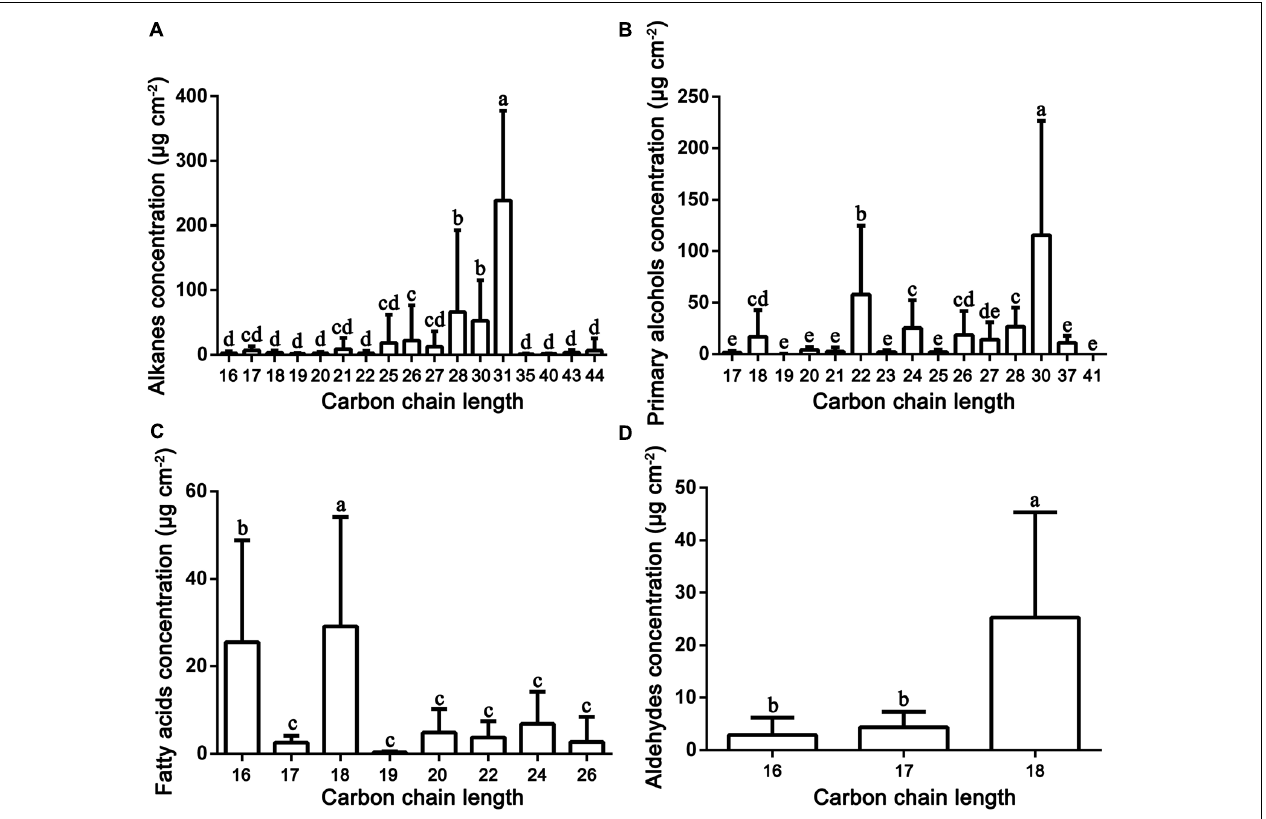
FIGURE 2 | Distribution and concentration of the main VLC aliphatic compounds detected in the epicuticular wax of 35 pear cultivars. (A) Alkanes; (B) primary alcohols, (C) fatty acids; and (D) aldehydes. Statistical significance was determined using Student’s t -test. Each value is the mean ± SD of three biological repeats. Different letters above each bar indicate significant differences at the 5%